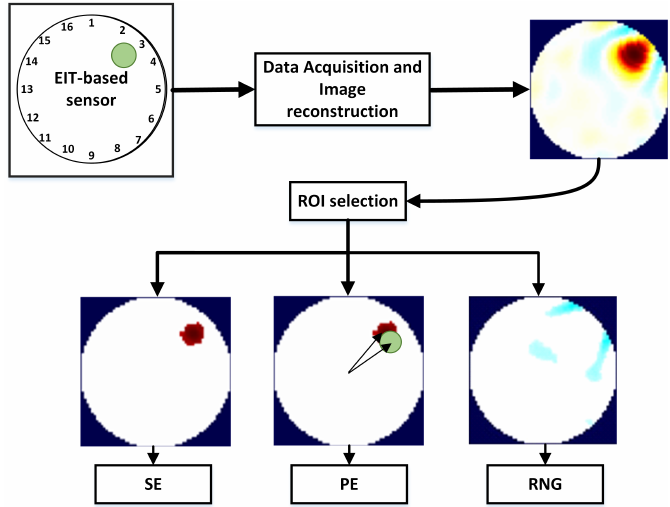
Figure 2. Performance parameters for the reconstructed image. On the top left, the EIT-based sensor, and in green the target placed over it. After the voltage data is acquired, the image of the conductivity change is reconstructed (top right, ( ˆ x O ) ). Then, the Region Of Interest (ROI) is selected and the parameters of Size Error (SE), Position Error (PE) and Ringing (RNG) are calculated from the post-processed image ( ˆ x P )